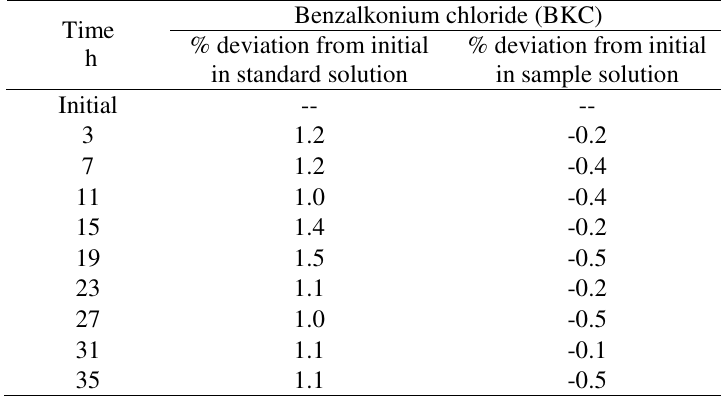
Table 1. Data of standard & sample solution